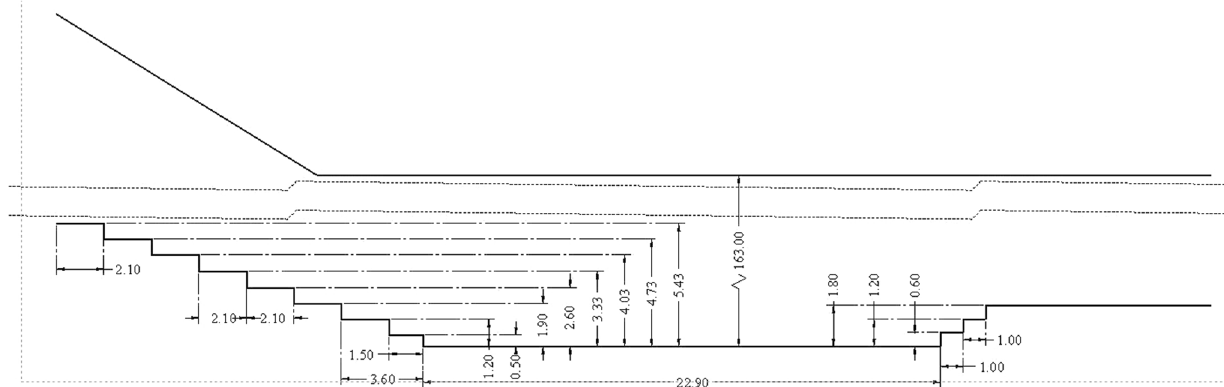
Fig. 1 Longitudinal section of the studied